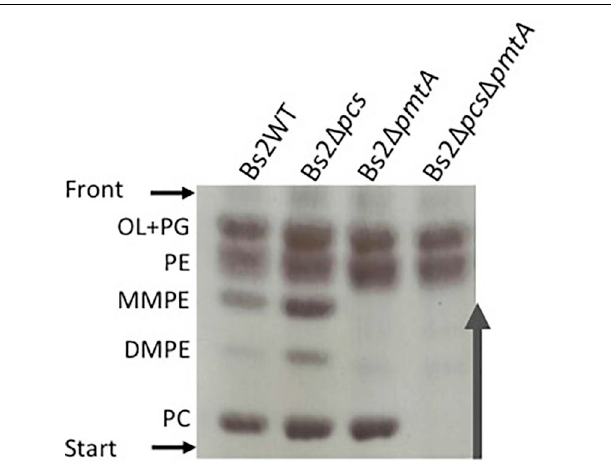
FIGURE 2 | Phosphatidylcholine synthesis in Bs2WT takes place through the methylation (PmtA) and the phosphatidylcholine synthase pathway (Pcs). HPTLC analysis of the free lipids of Bs2WT, Bs2 (cid:49) pcs , Bs2 (cid:49) pmtA , and Bs2 (cid:49) pcs (cid:49) pmtA grown in TSB. OL, ornithine lipids; PG, phosphatidylglycerol; PE, phosphatidylethanolamine; MMPE, mono-methyl-phosphatidylethanolamine; DMPE, dimethyl-phosphatidylethanolamine; PC,